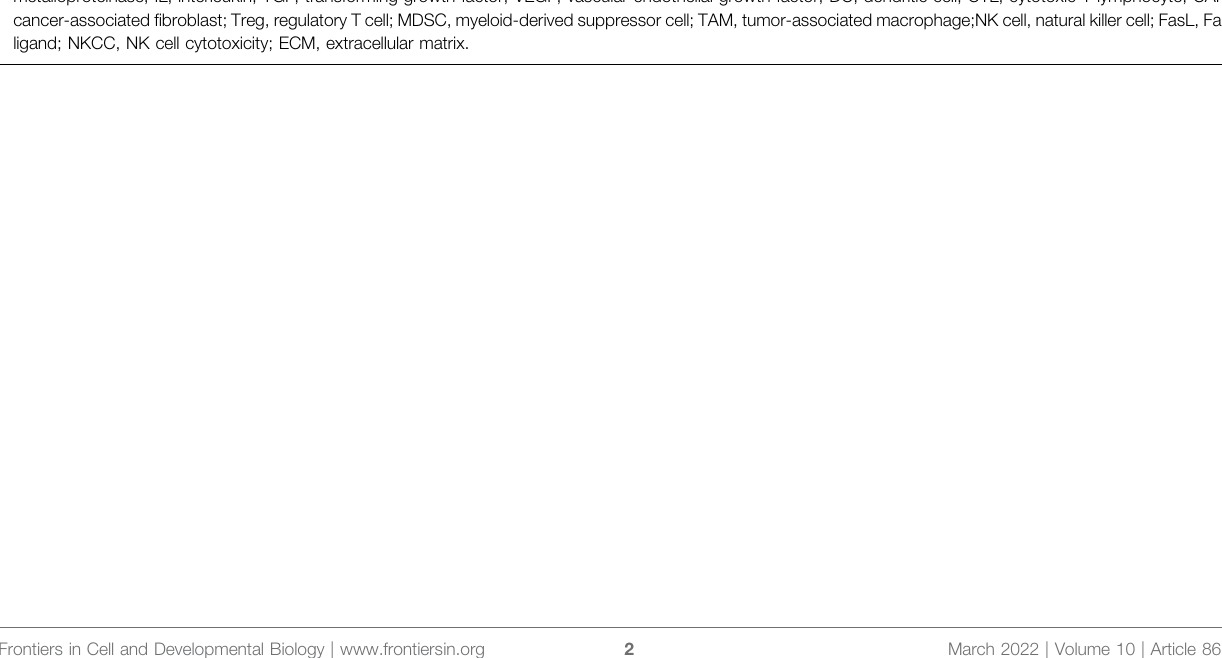
Frontiers in Cell and Developmental Biology |